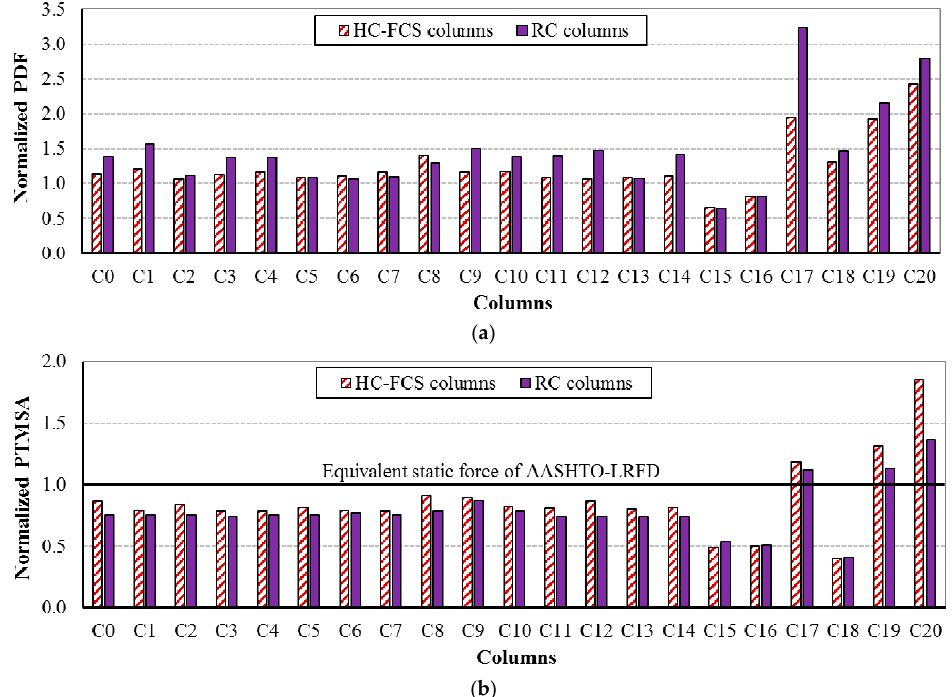
Figure 5. Normalized forces for all of the investigated columns: ( a ) normalized PDF and ( b ) normalized PTMSA.